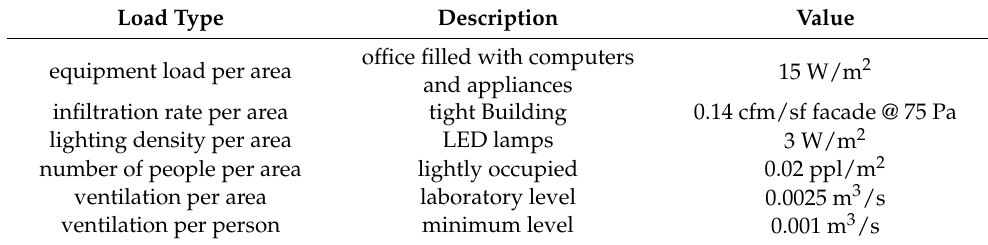
Table 4. Target region